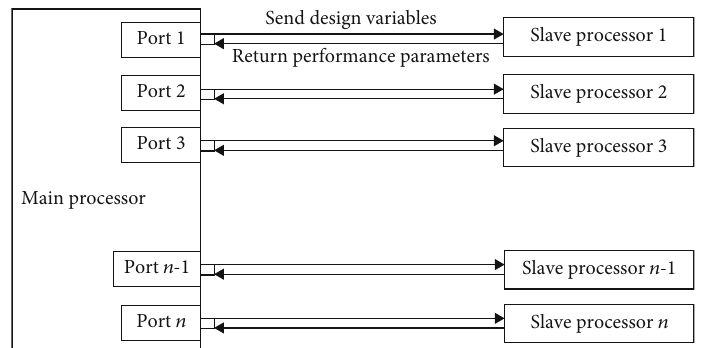
Figure 2: Block diagram of parallel communication in the genetic algorithm optimization process.